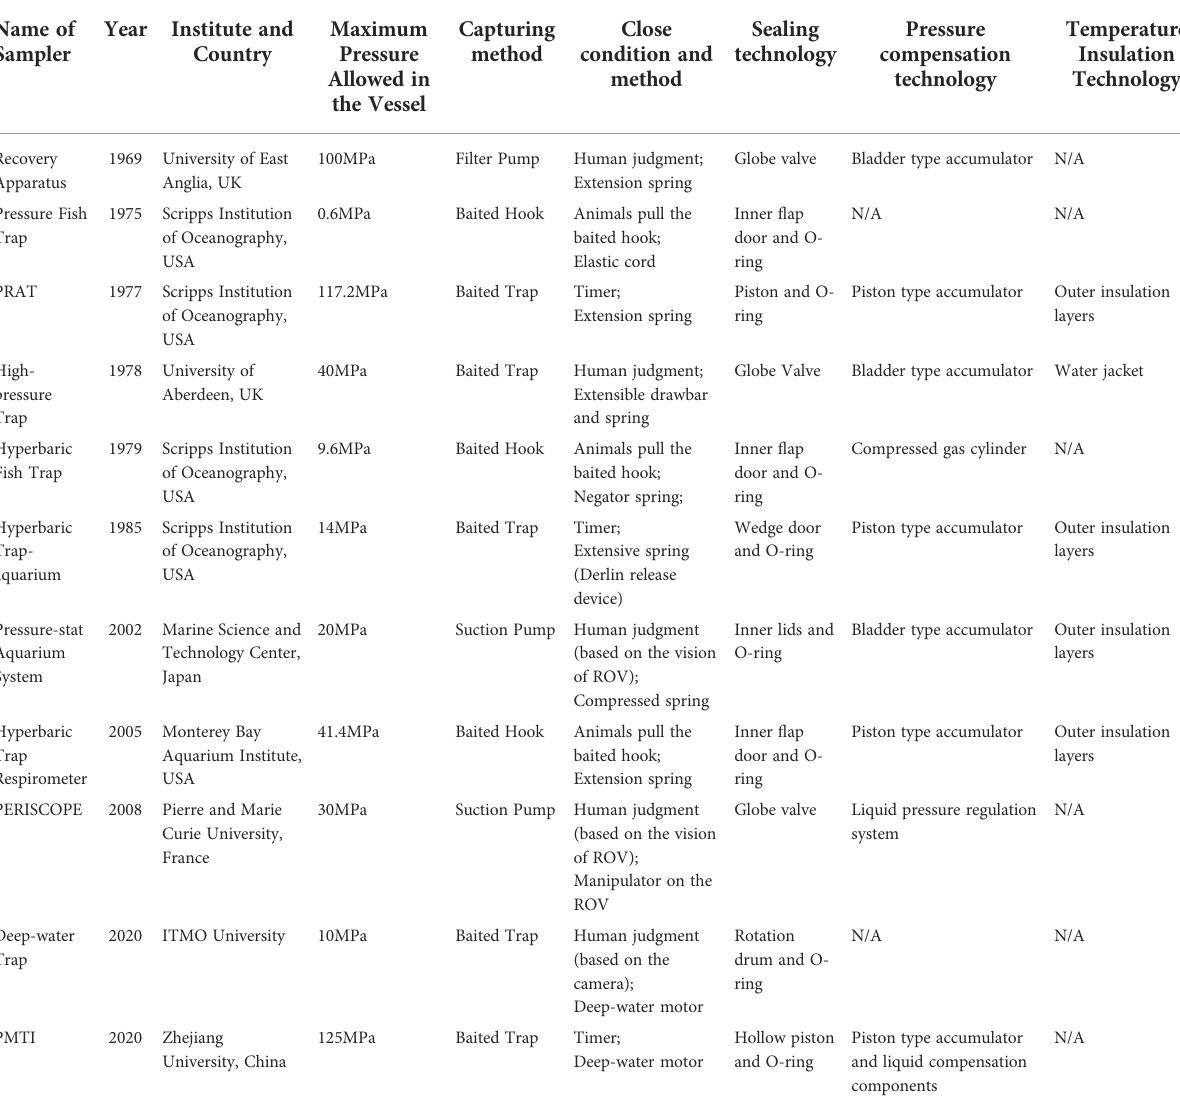
TABLE 1 Isobaric samplers and the key technologies. Name of